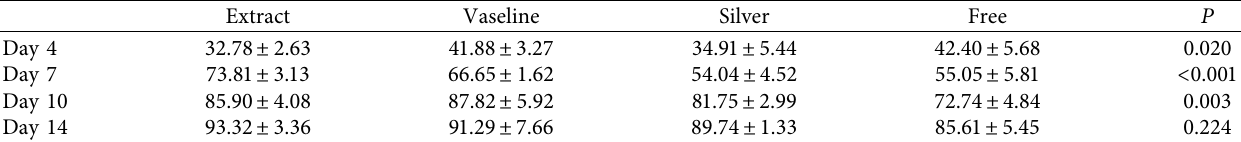
Table 5: Wound healing ratio (the ratio of wound healing � (area of original wound − area of remaining wound)/area of original wound × 100), in the silver sulfadiazine, free, Vaseline, and extract groups during the study on days 4, 7, 10, and 14.